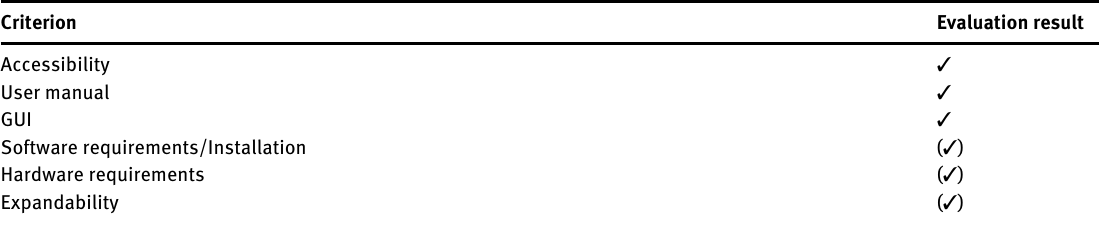
Table 1: Usability study. The introduced criteria in grid screener [29] are evaluated. Thereby, ‘‘ ✓ ’’ indicates full, ‘‘( ✓ )’’ partial, and ‘‘ x ’’ no target